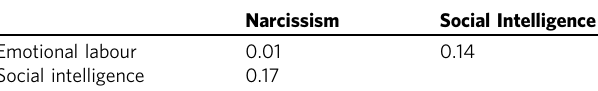
Table 8 Effect S ize ( f 2